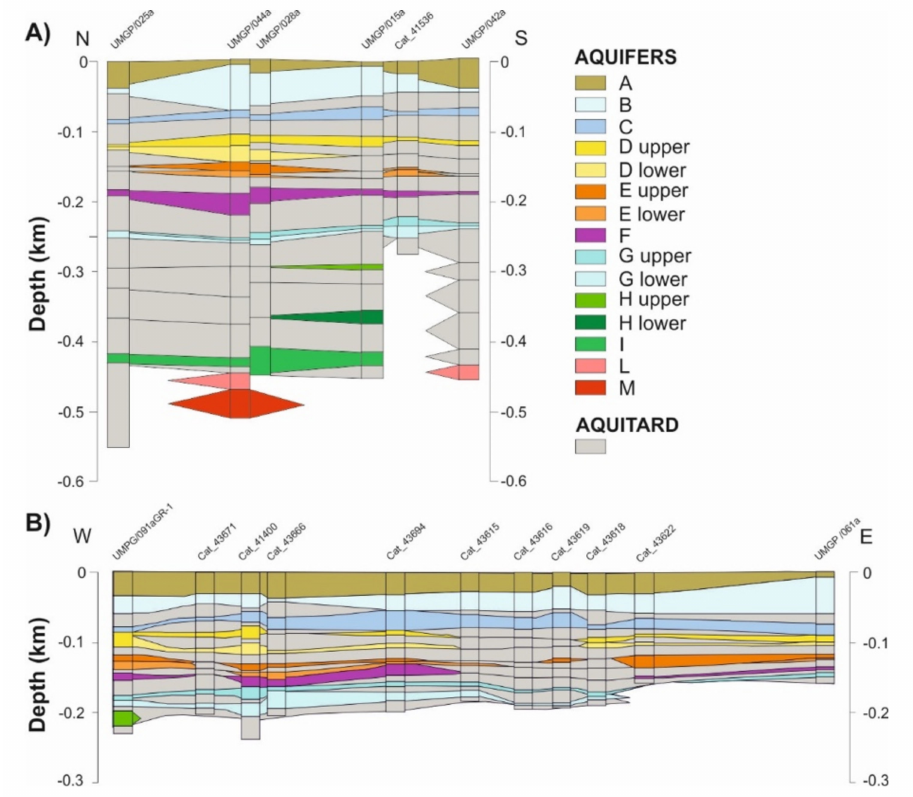
Figure 2. Correlation among the aquifers along the two selected profiles with directions N-S (Lignano profile) ( A ) and NE-SW (Grado profile) ( B ), respectively. The position of the two profiles N-S and NE-SW is reported in Figure 1 with yellow and red lines, respectively. The profiles were developed on the basis of available well information [28]. The grey layers represent the aquitard, while the other ones are the identified aquifers. The nomenclature of the aquifers is from